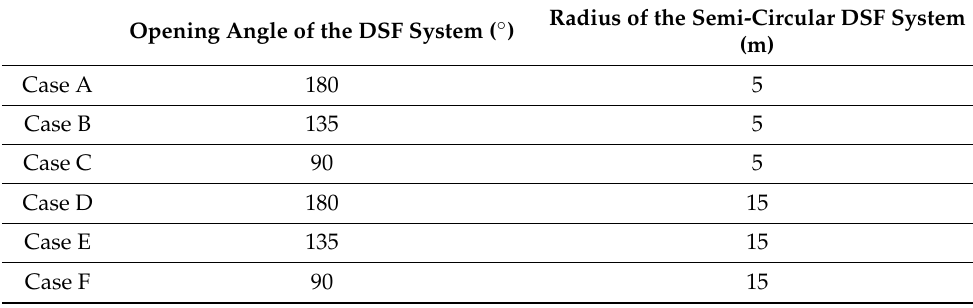
Table 1. The opening angle of the DSF system and the radius of the curved DSF system. Radius of the Semi-Circular DSF Opening Angle of the DSF System ( ◦ )